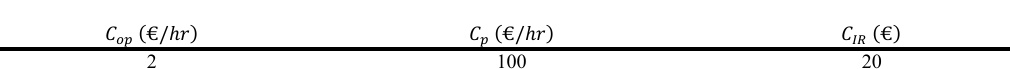
Table 1. Cost parameters used in this